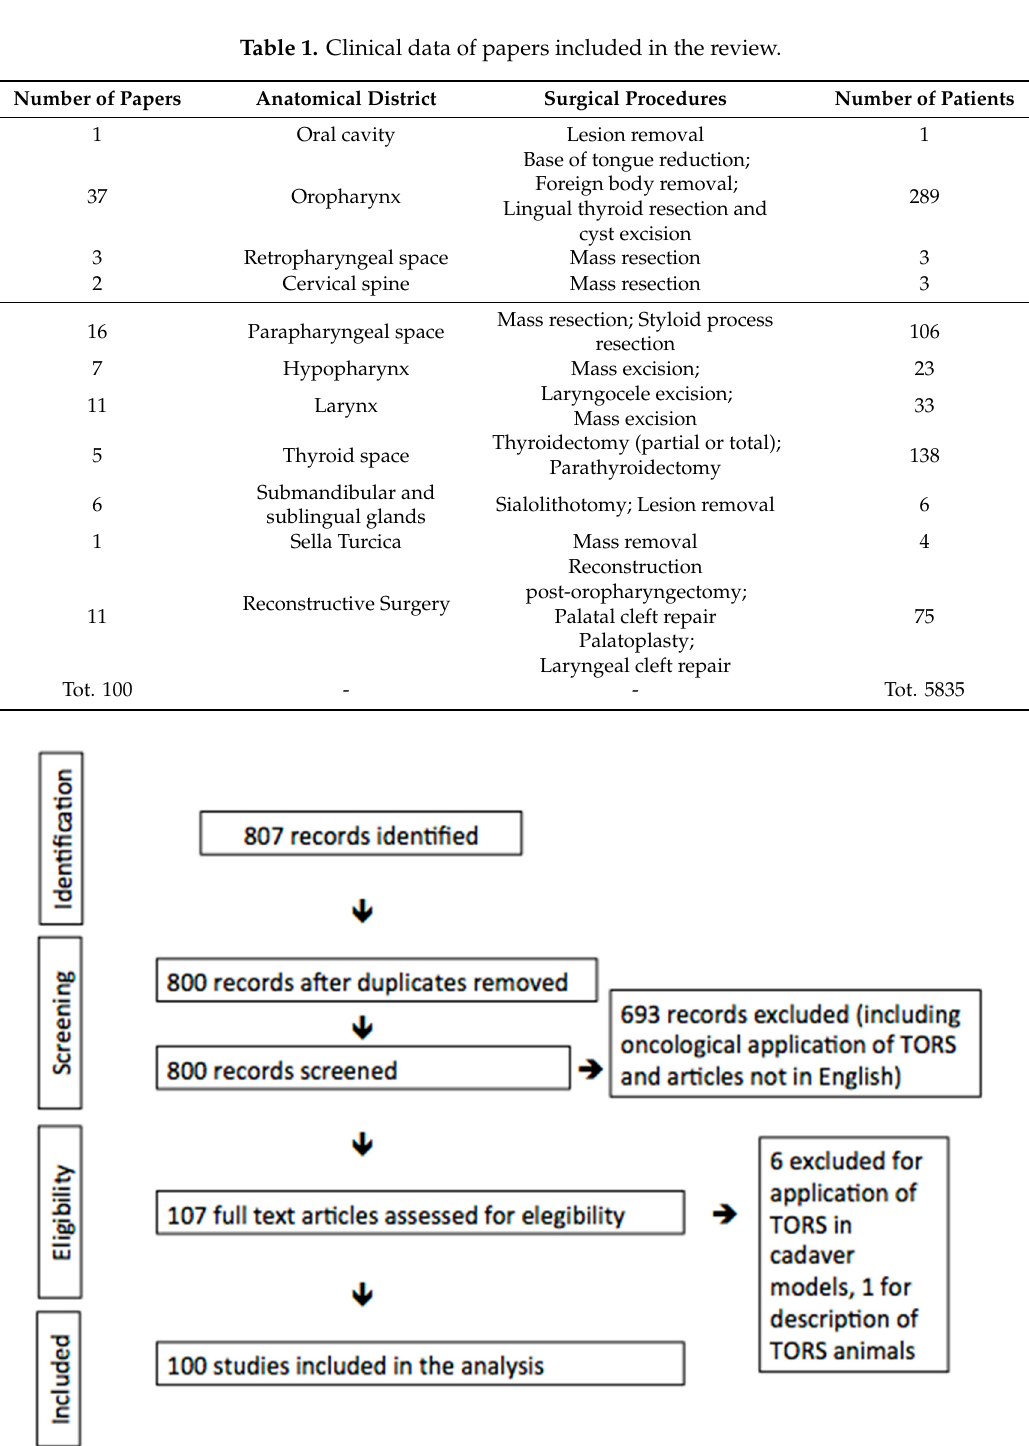
Figure 1. Preferred Reporting Items for Systematic Reviews and Meta-Analyses (PRISMA) graph. TORS: trans-oral robotic surgery.